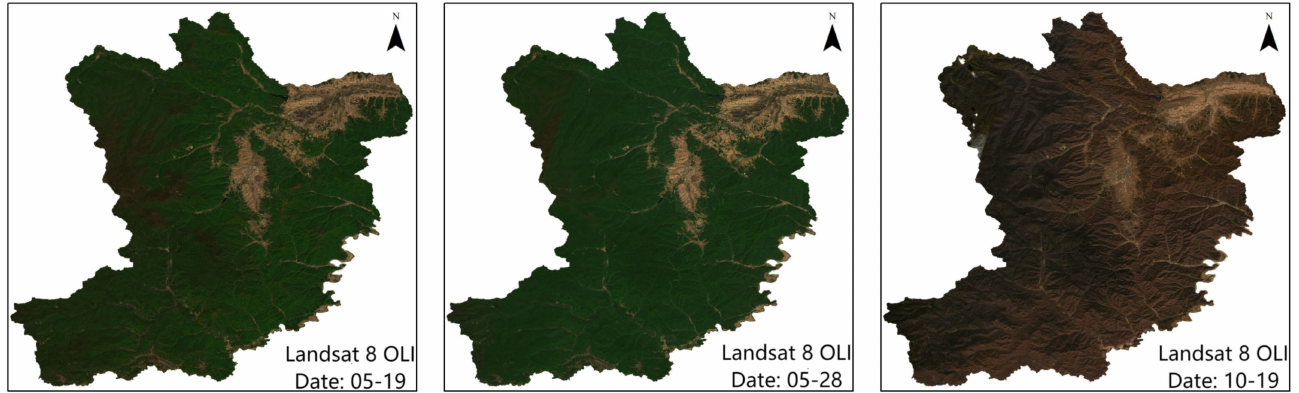
Figure 6. Real Landsat images on the base date and predicted